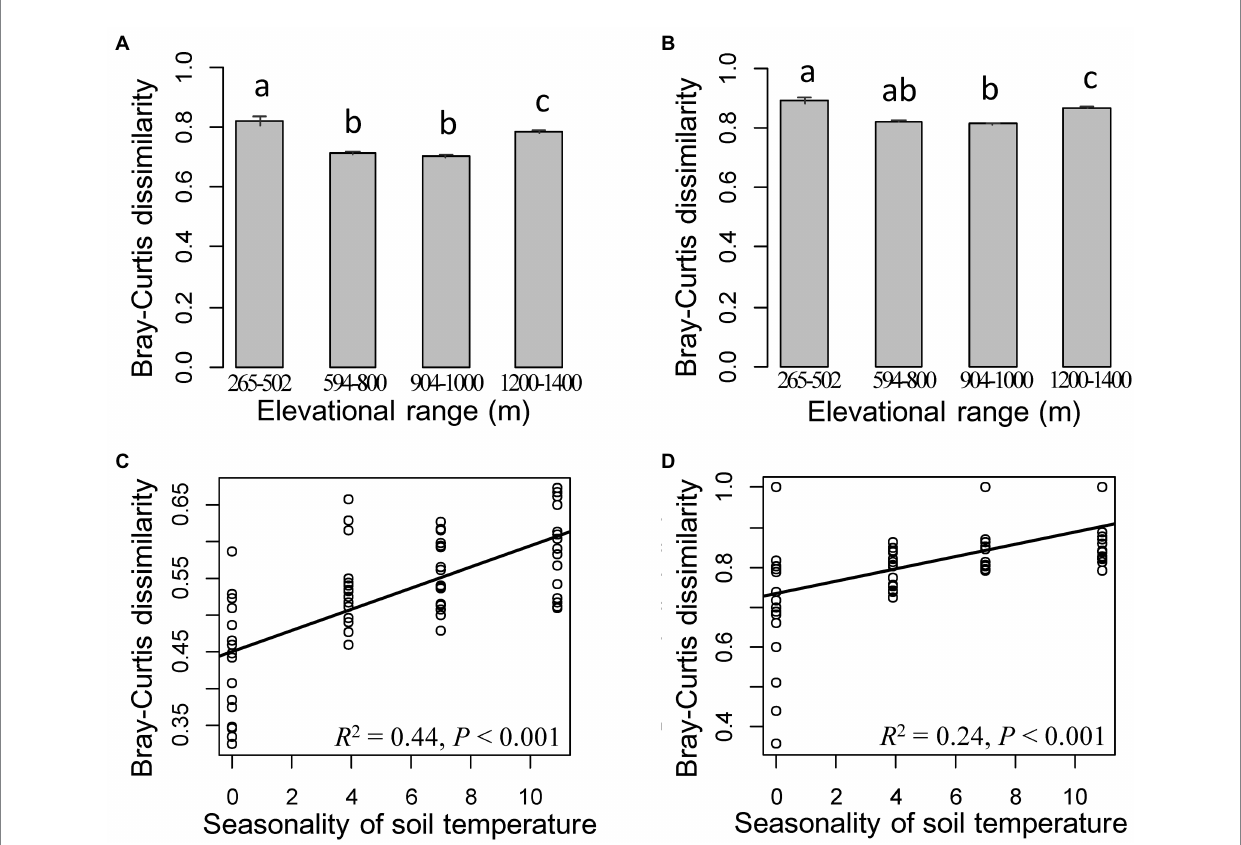
FIGURE 3 Compositional dissimilarity among cloud forests from elevational range of 1,200–1,400 m and other elevational ranges for bacteria (A) and fungi (B) . Differences are significant when no same letter exists between elevational ranges (one-way ANOVA followed by Dunnett’s test; p < 0.05). The most important predictor of compositional dissimilarity for bacteria (C) and fungi (D) in cloud forests from elevational range of 1,200–1,400 m.a.s.l. The solid lines represent the fitted linear